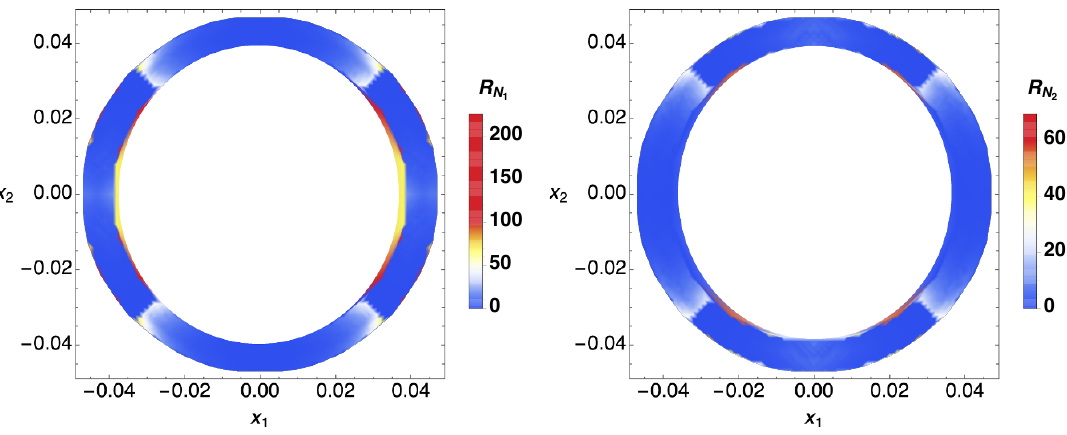
Figure 11 . Top panel: R N (cid:17) N 1 =(cid:17) N 2 with the model parameters x 1 and x 2 . Bottom B B 1 (cid:17) panel: R N (cid:17) N 2 =(cid:17) N 1 with the model parameters x 1 and x 2 . All the plots are generated B B 2 (cid:17)